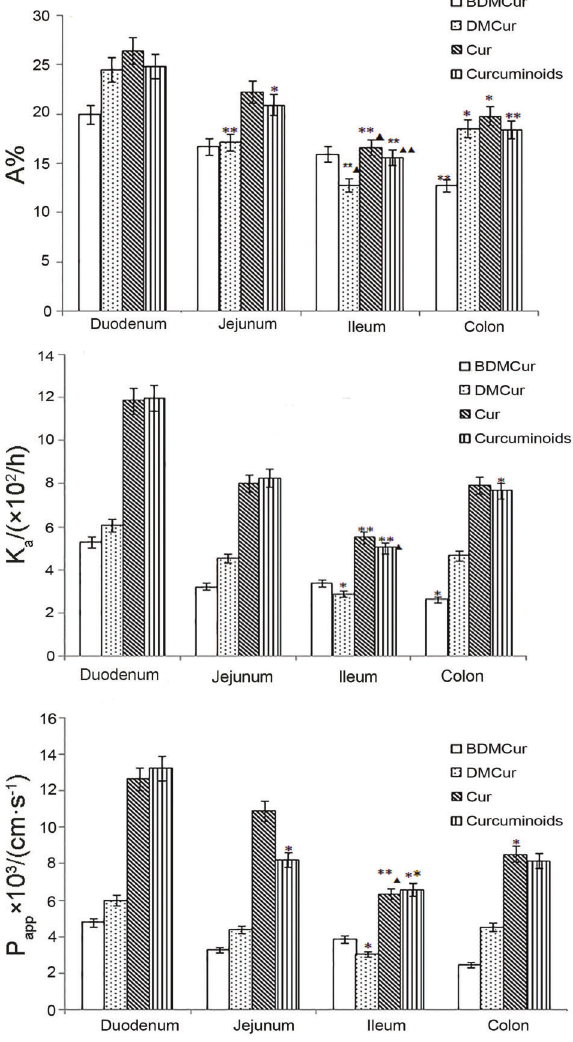
Figure 3 . Absorption parameters of bisdemethoxycurcumin (BDMCur), demethoxycurcumin (DMCur) and curcumin (Cur) in various intestinal segments from rats. Top : absorption percentage (A%); middle : absorption rate constant (K a ), and bottom : drug apparent absorption coef fi cient (P app ). *P o 0.05, **P o 0.01, compared to duodenum; m P o 0.05, mm P o 0.01 compared to jejunum